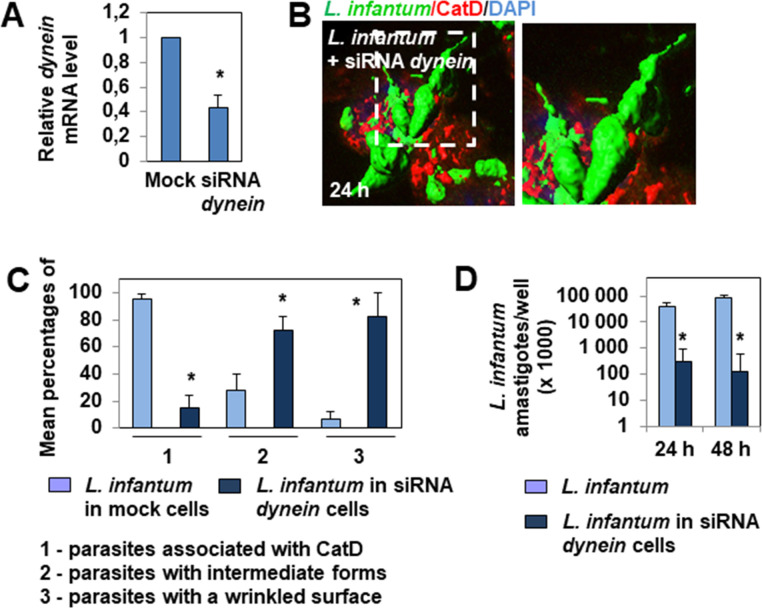
Silencing of the dynein gene in macrophage-like Raw 264.7 cells abolishes the maturation of L. infantum LEM 5700-containing phagosomes/PVs, delays parasite differentiation, and promotes parasite death.(A) Bar graph showing dynein mRNA levels relative to those of gapdh mRNA measured by RT-qPCR in mock and dynein siRNA-transfected cells. (B) 3D-reconstruction surface rendering confocal micrograph showing limited association of cathepsin D (CatD) with fusiform-like parasites hosted in an infected dynein siRNA-transfected cell, and the highly altered morphology of these parasites. For comparison, see the CatD decoration of parasites hosted in untreated cells in Fig 1G. (C) Bar graph showing the percentage of parasites associated with CatD, the percentage of intermediate parasite forms and amastigotes, and the percentage of parasites with a wrinkled cell surface in mock-transfected and siRNA dynein-transfected cells. (D) Bar graph showing the amastigote load determined by RT-qPCR in mock-infected cells and dynein siRNA-transfected infected cells. The confocal micrograph is representative of two or three independent experiments. The high-magnification view corresponds to the white dashed box. The percentage of parasites was determined by analyzing at least 30 cells for each condition. The percentage of parasites with a smooth or wrinkled cell surface was determined by analyzing parasites hosted in at least 20 cells for each condition. Dynein mRNA levels were quantified by RT-qPCR of over three independent biological samples for each time-point. Amastigote levels per culture well were quantified by RT-qPCR in two independent experiments in duplicate. Data are presented as averages ± SEM and were analyzed by the unpaired Student t test. *p < 0.01.